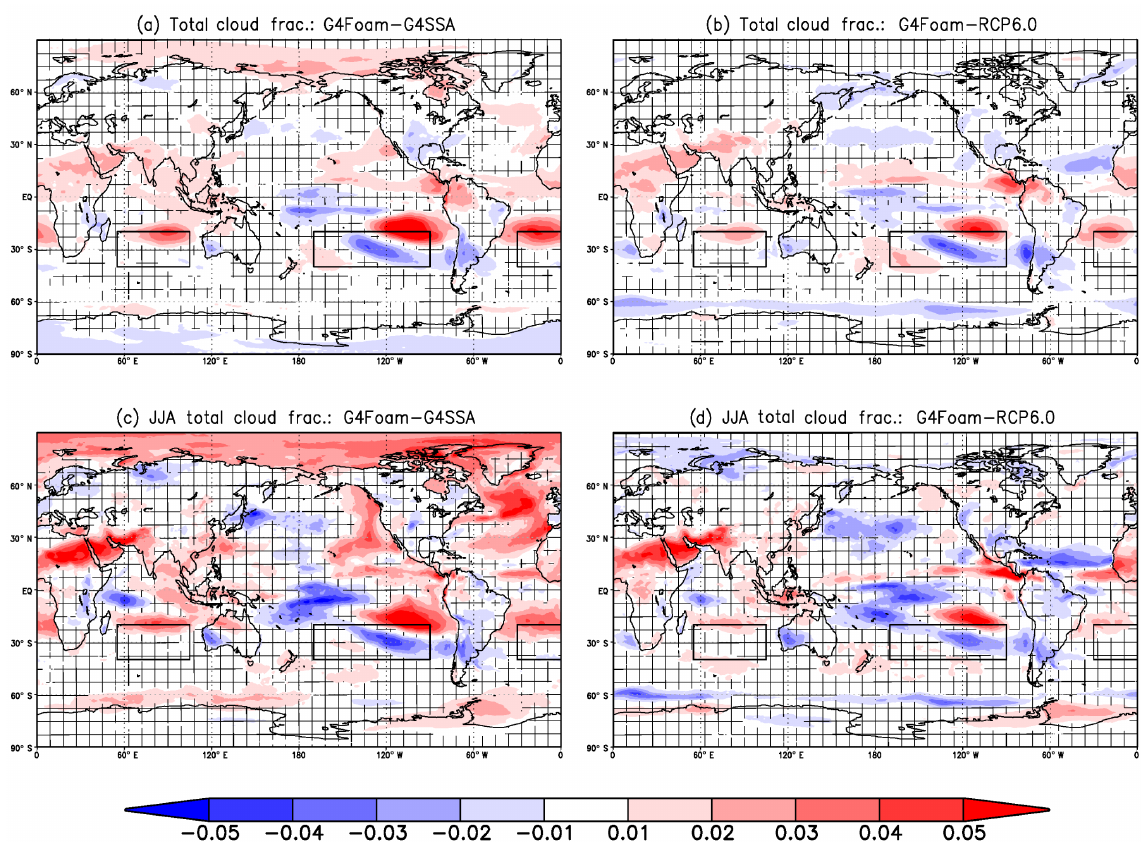
Figure 6. 2030–2069 total cloud fraction difference (unitless) between G4Foam and (a) G4SSA, (b) RCP6.0, (c) G4SSA during JJA, and (d) RCP6.0 during JJA. Hatched regions are areas with p >0.05 (where changes are not statistically significant based on a paired t test). Black boxes enclose foamed